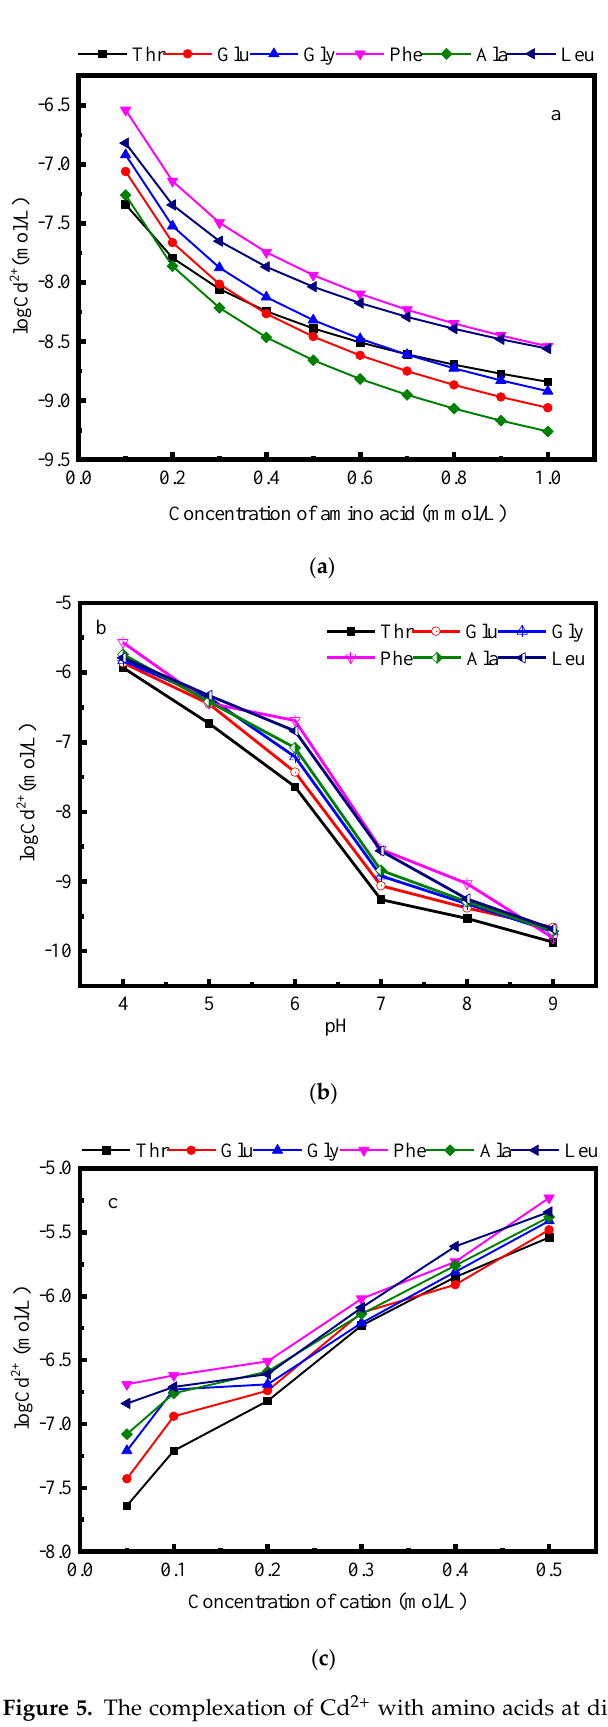
Figure 5. The complexation of Cd 2+ with amino acids at different ( a ) amino acid concentrations, ( b ) pH, and ( c ) cation concentrations.